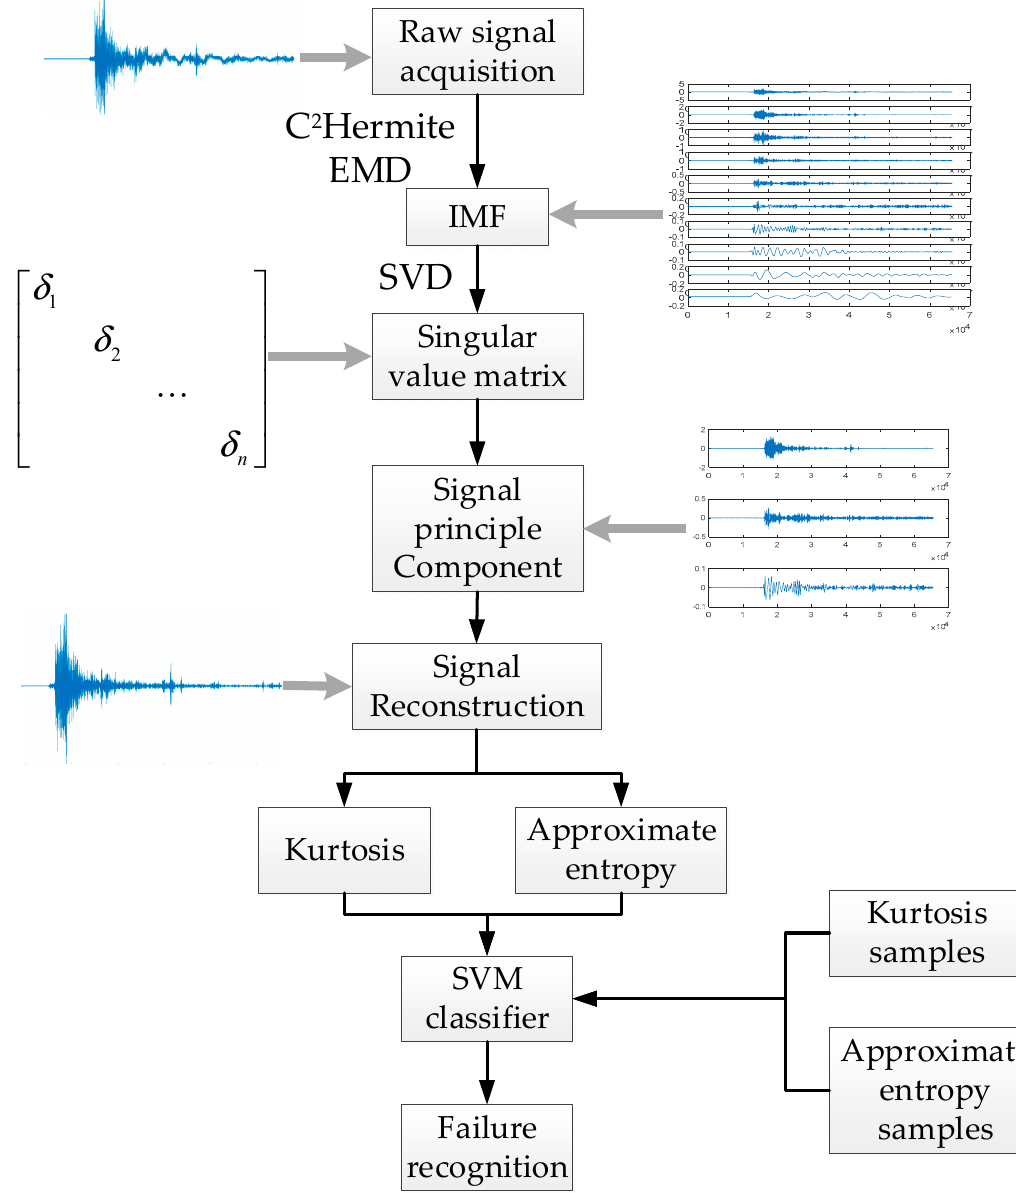
Figure 2. Flow chart of fault diagnosis.